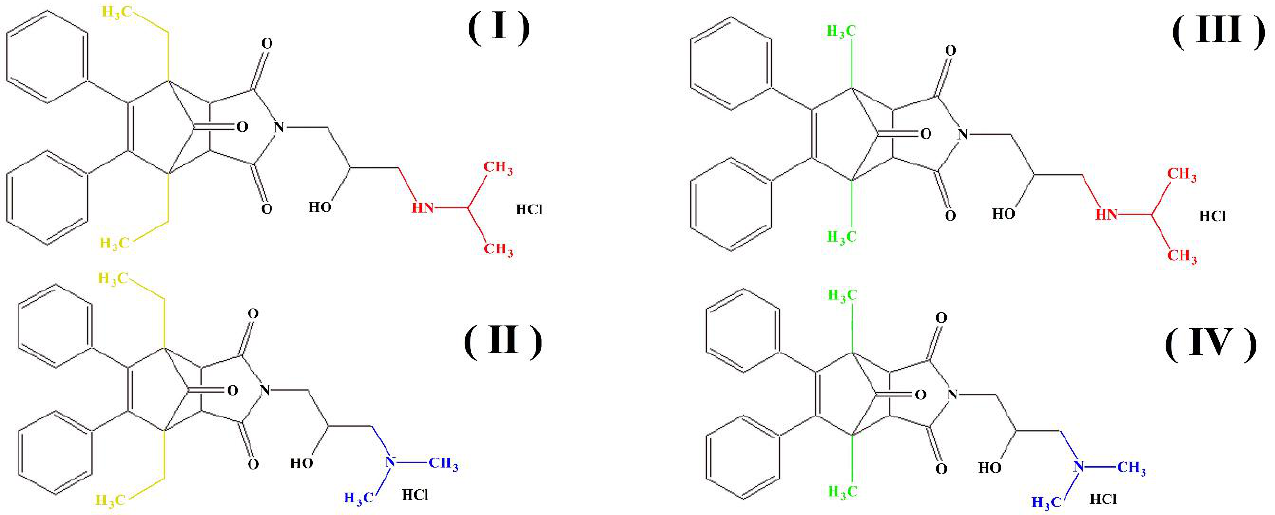
Figure 1. Structures of aminoalkanol derivatives ( I ), ( II ), ( III ) and ( IV ).